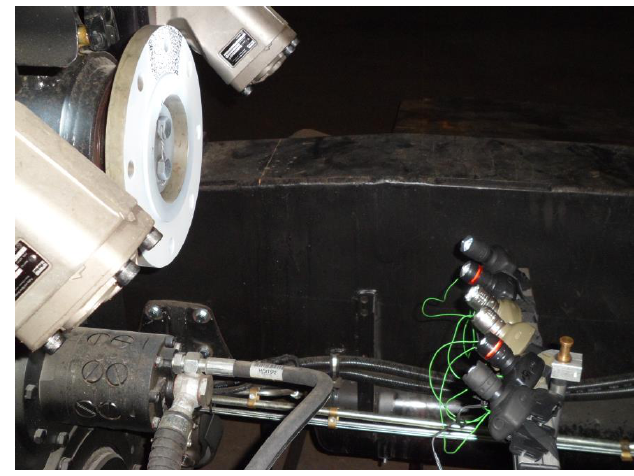
Figure 15. The experimental setup